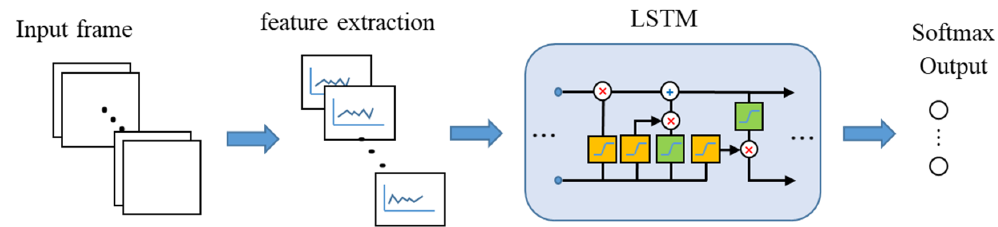
Figure 9. Flow chart of the long short-term memory (LSTM) network.